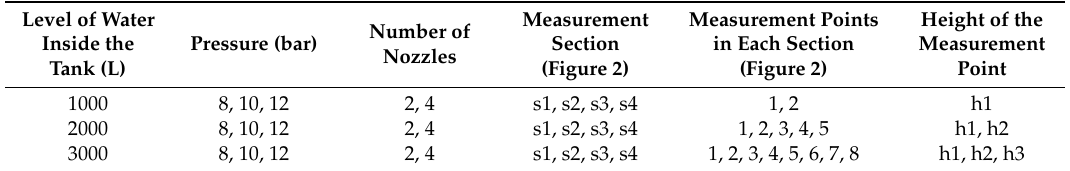
Figure 4. ( a ) Cross sections of where velocity measurements were made inside the tank (dimensions in millimeters); ( b ) Velocity measurement points within each of the four sections. Table 3. Factorial design of experimental velocity measurements inside the tank according to the configuration variables and the location of the measurement.